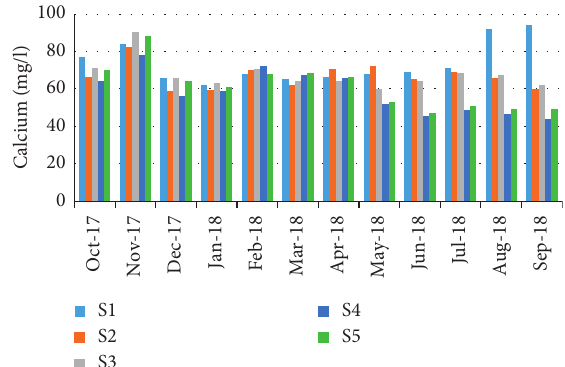
Figure 7: Spatial-temporal variation of suspended matter in the Zegzel watercourse.